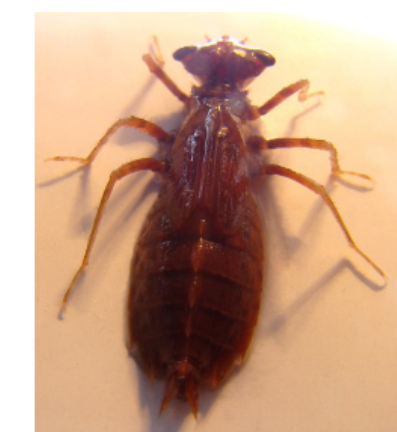
Image 2d. Leucorrhinia sp.